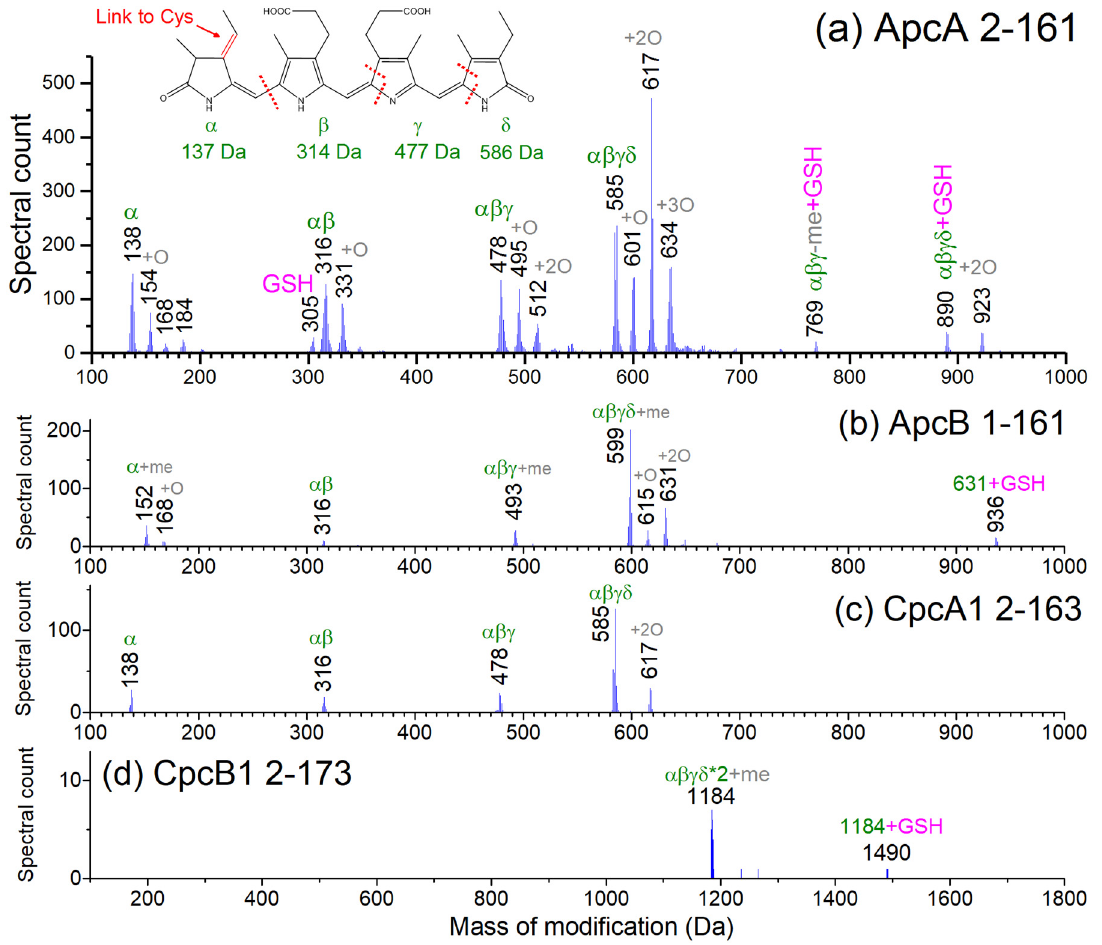
Figure 3. Histogram of detected modifications on full-length ( a ) ApcA, ( b ) ApcB, ( c ) CpcA, and ( d ) CpcB as revealed by top-down proteomics. Spectral counts were calculated based on data from all samples. The modification masses detected on the intact ApcA protein shows clusters of species that can be explained by cleavages between the α , β , γ , δ pyrrole rings in the PCB structure (Figure 4a insert), plus combinations of methylation (me), oxidation (O), and glutathionylation (GSH). Similar but generally fewer types of modifications were observed for ApcB, CpcA with one chromophore each, and CpcB with two chromophores.